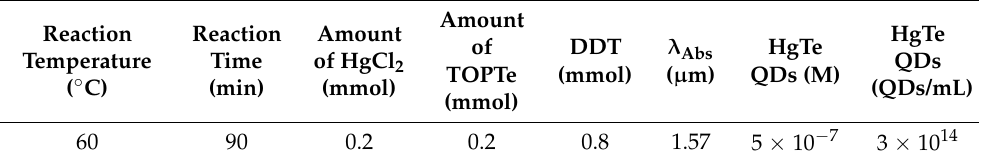
Table 1. Parameters of the preparation of MTQD colloidal suspensions. λ Abs is the wavelength of maximal absorbance in the IR range, HgTe QDs (M) is the molar concentration, HgTe QDs (QDs/mL) is the number of QDs in 1 mL.